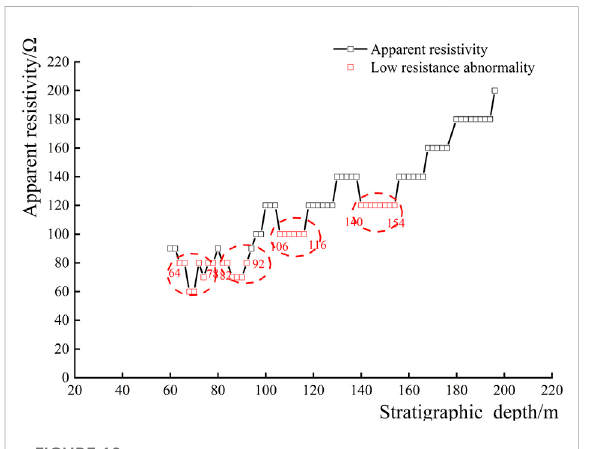
FIGURE 10 Relationship between formation depth and apparent resistivity at point 3 of the Y 3 line.